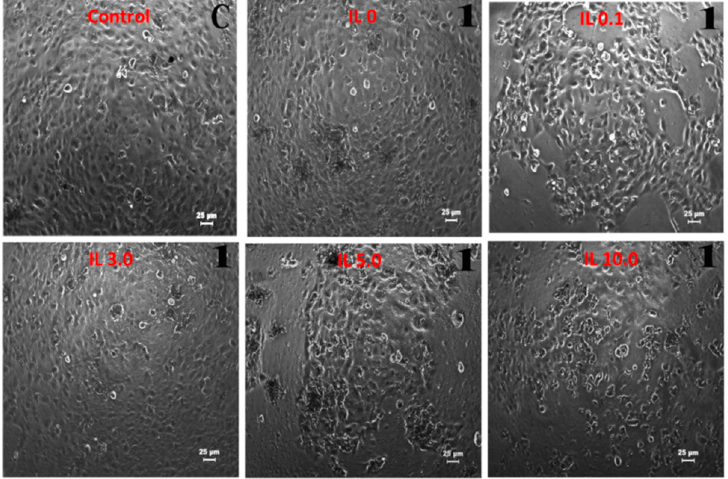
Figure 7. Morphological changes observed in the Swiss cells for the treatment with gels samples for a concentration of 1 µg/mL.